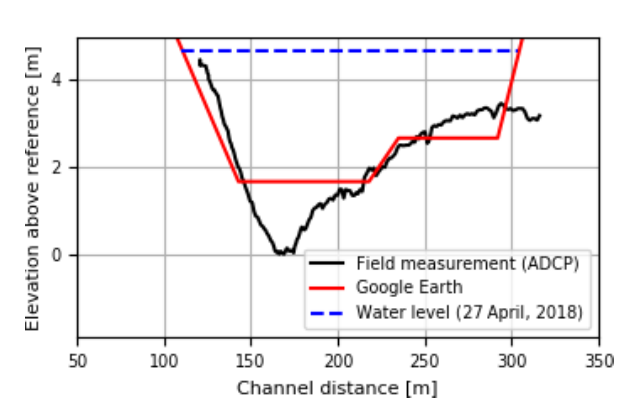
Figure 5. River cross section at Luangwa Bridge obtained from Google Earth and detailed field survey including the river water level on 2 June 2008. Field measurements were done with an Acous- tic Doppler Current Profiler (ADCP) on 27 April 2018 at the coordi- nates 30 ◦ 13 (cid:48) E and 15 ◦ 00 (cid:48) S; the satellite image was taken on 2 June 2008. The reference level is equal to the lowest elevation level mea- sured with the